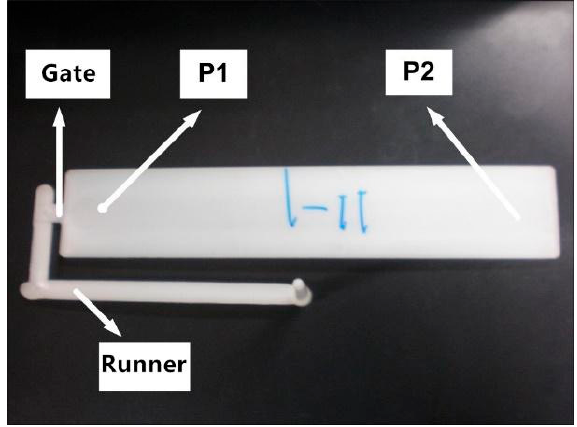
Figure 5. Two sensors capturing cavity pressure at P1 and P2.